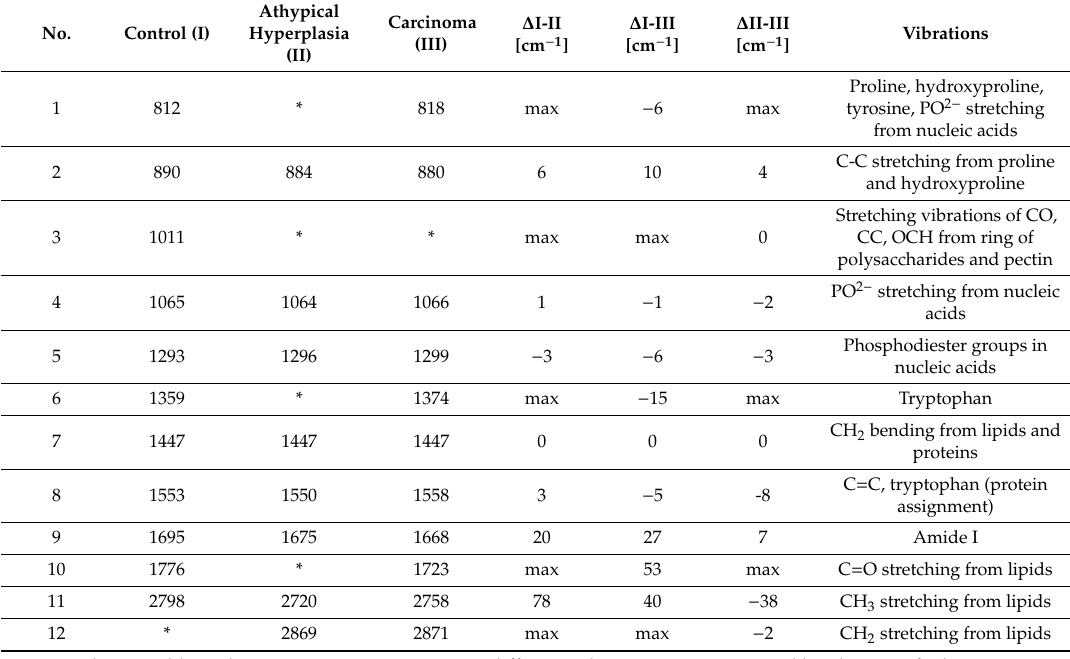
*-Band not visible in the spectrum; max–maximum di ff erences between spectra caused by absence of vibrations in one of the analyzed spectra; ∆ I-II, ∆ I-III, ∆ II-III: di ff erences in the peak positions between analyzed samples. FTIR spectra can be divided into three basic groups corresponding to the basic building blocks of cell components. The following spectral regions can be distinguished: of the region 1000–1250 cm